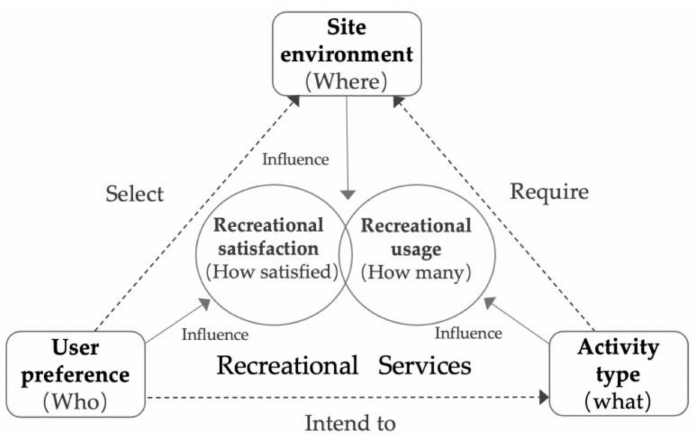
Figure 1. The recreational services function mechanism in a